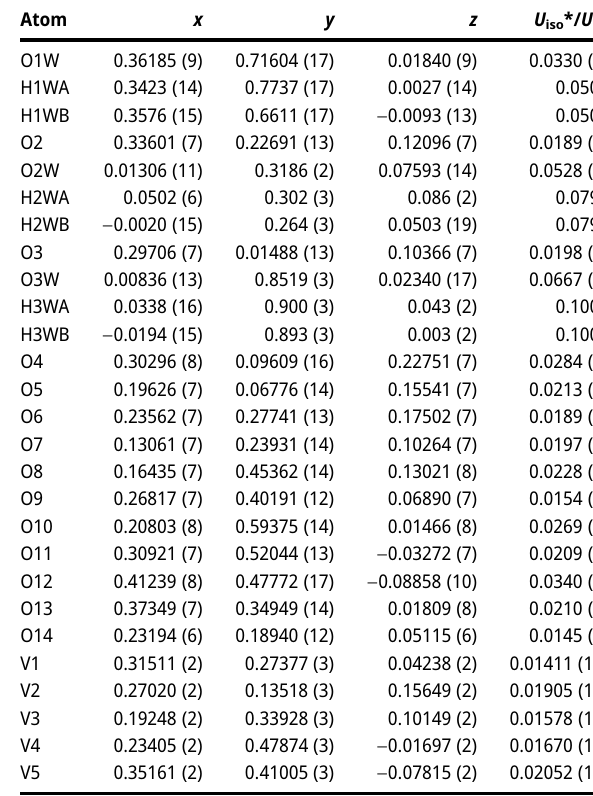
Table  : Fractional atomic coordinates and isotropic or equivalent isotropic displacement parameters (Å 